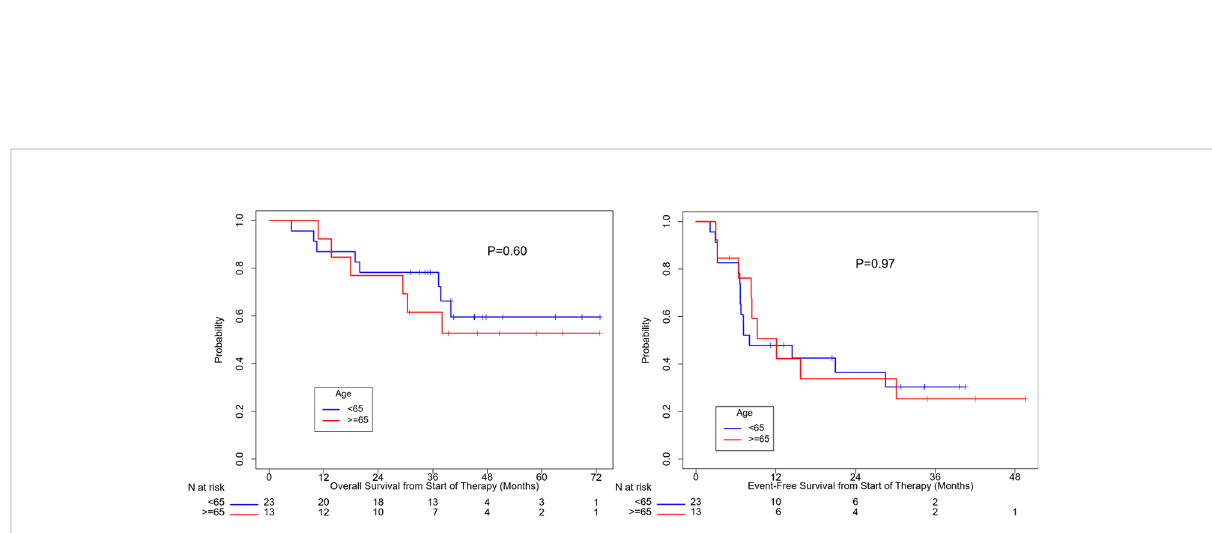
FIGURE 4 Overall survival and event free survival strati fi ed based on age at